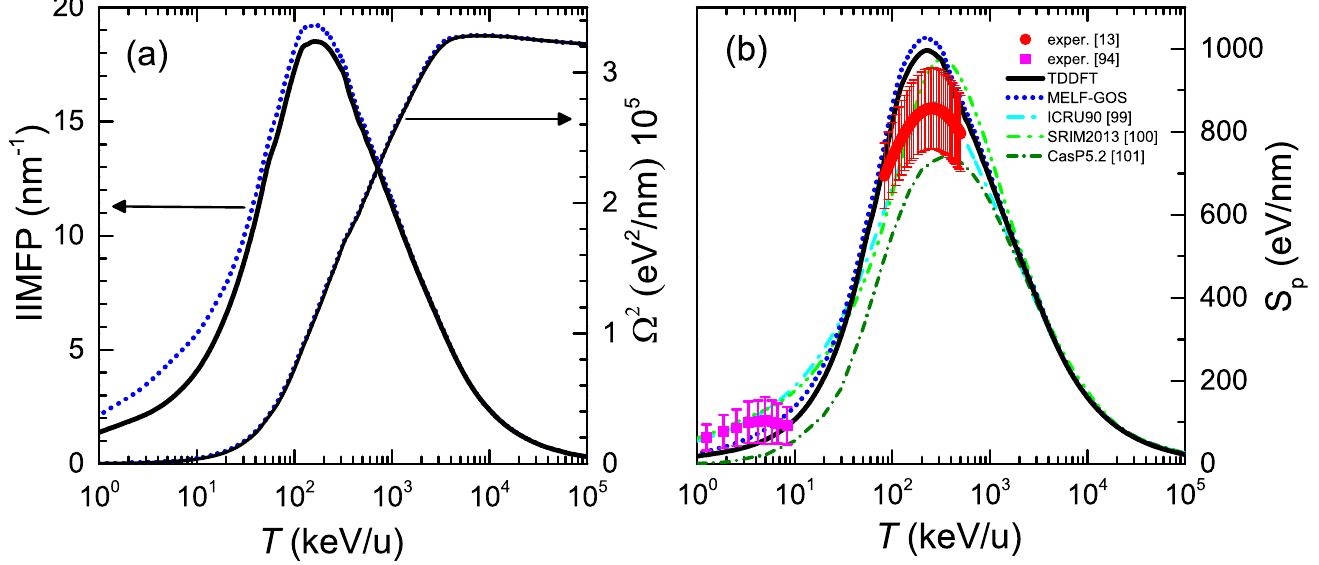
Figure 3. Energy-lossquantities of carbon ions in liquid water as a function of the incident projectile energy T . Black solid (blue dotted) lines correspond to our calculations when the liquid water ELF is described by the LR-TDDFT (MELF-GOS) approach. ( a ) Inverse inelastic mean free path (IIMFP) (left side axis) and energy-loss straggling Ω 2 (right side axis). ( b ) Electronic stopping power. Available experimental data for liquid water are shown by red circles [13] and measurements for water molecules are depicted by magenta squares [94]. Other models and simulations are also shown (see the text for